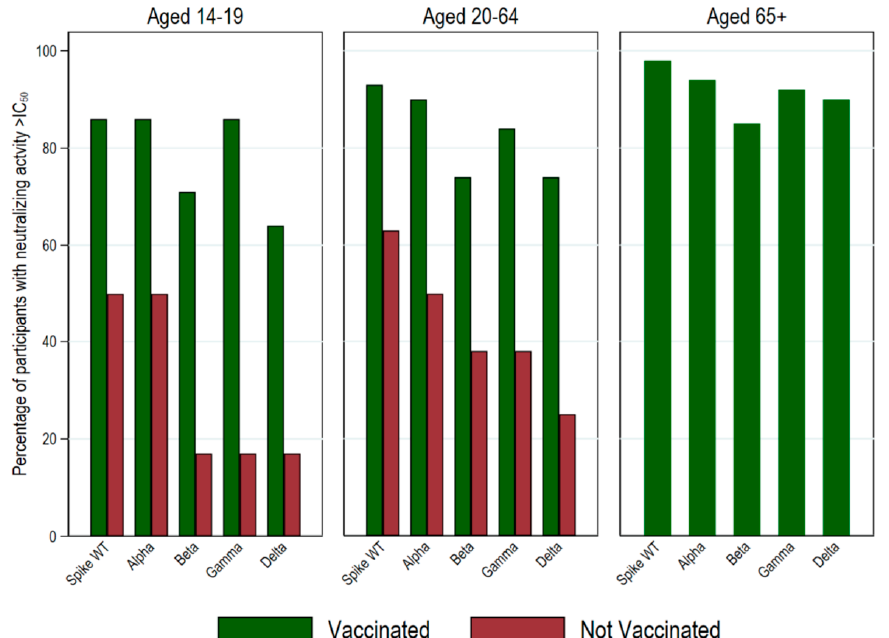
Figure 6. Neutralizing activity against SARS-CoV-2 variants by vaccination status across age groups in the sub-sample of seropositive participants at the third serosurvey in June–July 2021 (N = 250: 65+ years N = 125; 20–64 years N = 105; 14–19 years N = 20). The y -axis indicates the percentage of participants with an above IC 50 threshold neutralizing activity by self-reported vaccination status at the June–July 2021 serosurvey.